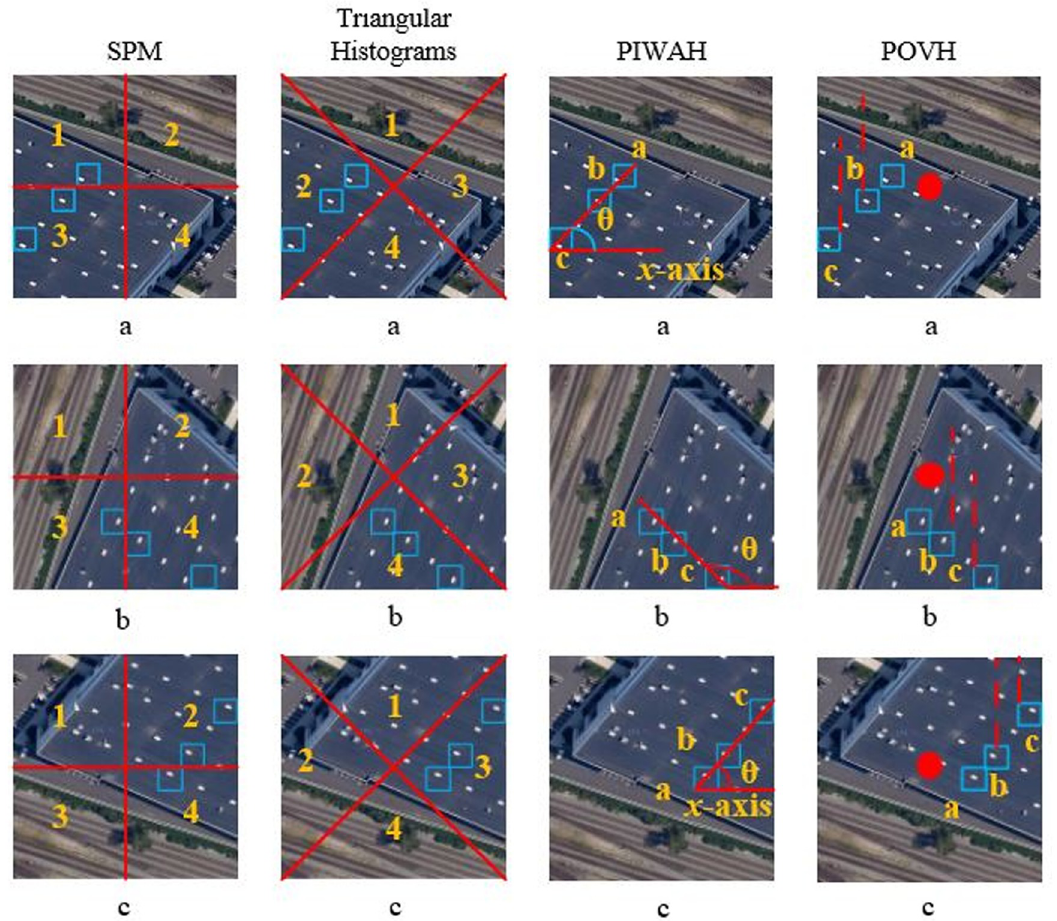
Fig 12. Image representation based on different spatial approaches where (a) represents the original image, (b) the image rotated by 90˚, and (c) image rotated by 180˚.